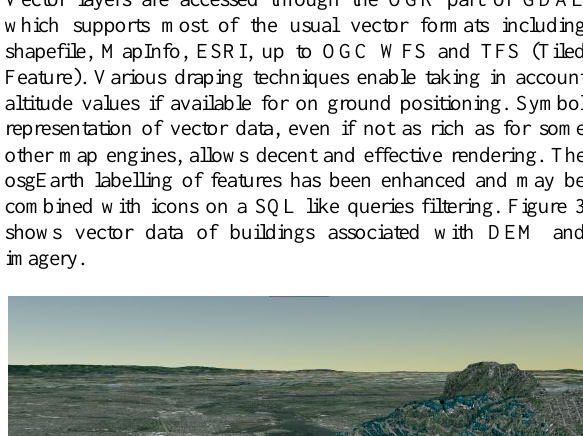
Figure 5 - Video draping on terrain